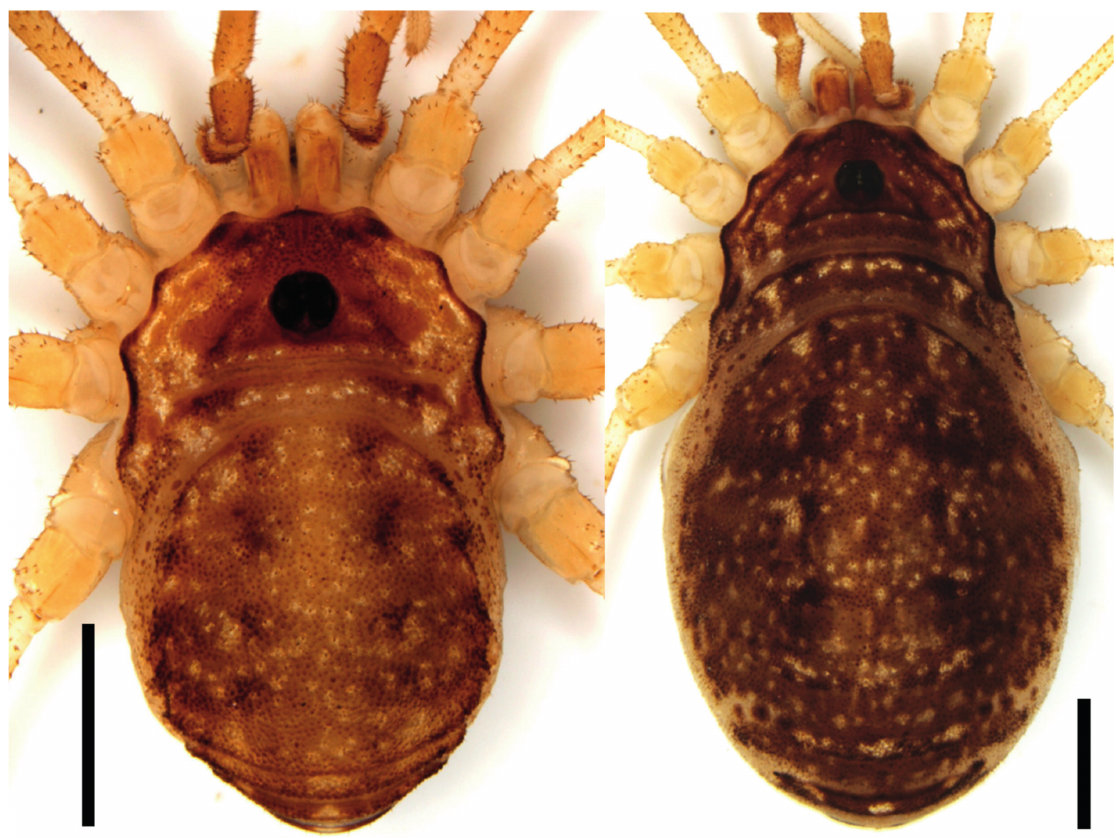
Fig. 1. Leiolima iberica gen. et sp. nov. Dorsal view of the male holotype (MNCN 20.02/17372) (left, body length 3.15 mm) and a female paratype (MNCN 20.02/17374) (right, body length 5.58 mm). Scale bars: 1